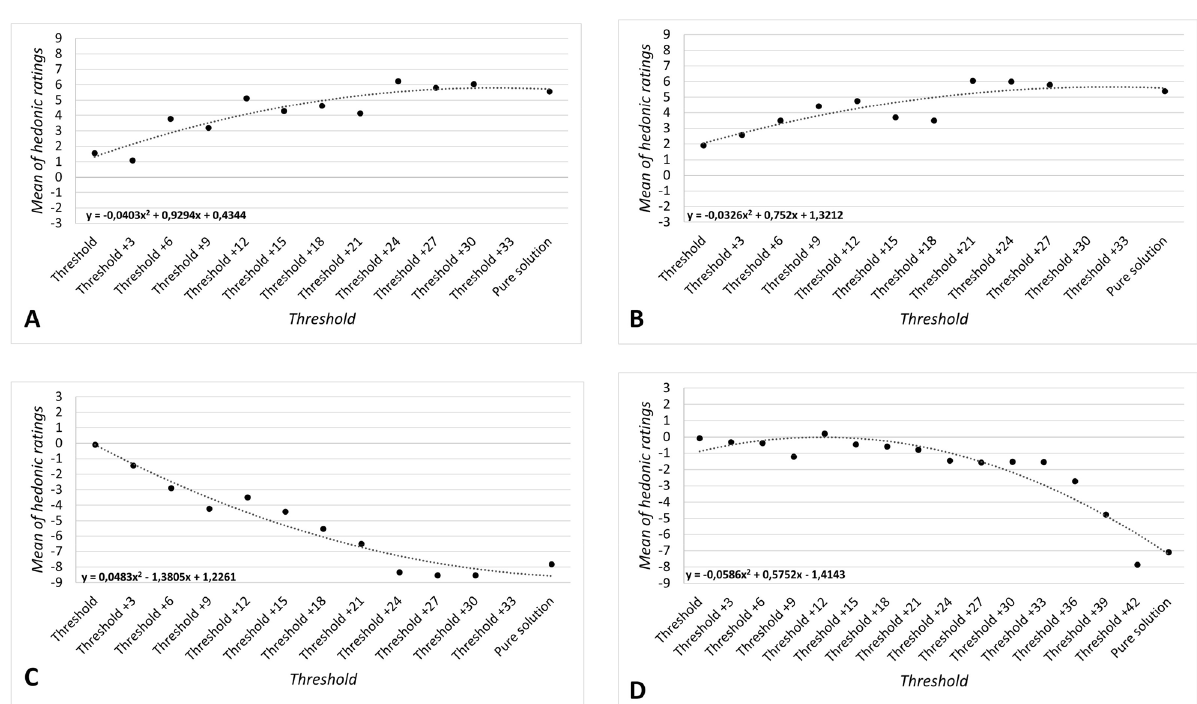
Figure 5. Odor hedonic ratings above odor detection thresholds: mean hedonic ratings in relation to individual detection threshold in step of 3 concentrations. ( A ) apple, ( B ) jasmine, ( C ) durian, ( D ) trimethylamine. The line grey color responds to the polynomial regression. Equations of polynomial regressions is given on each